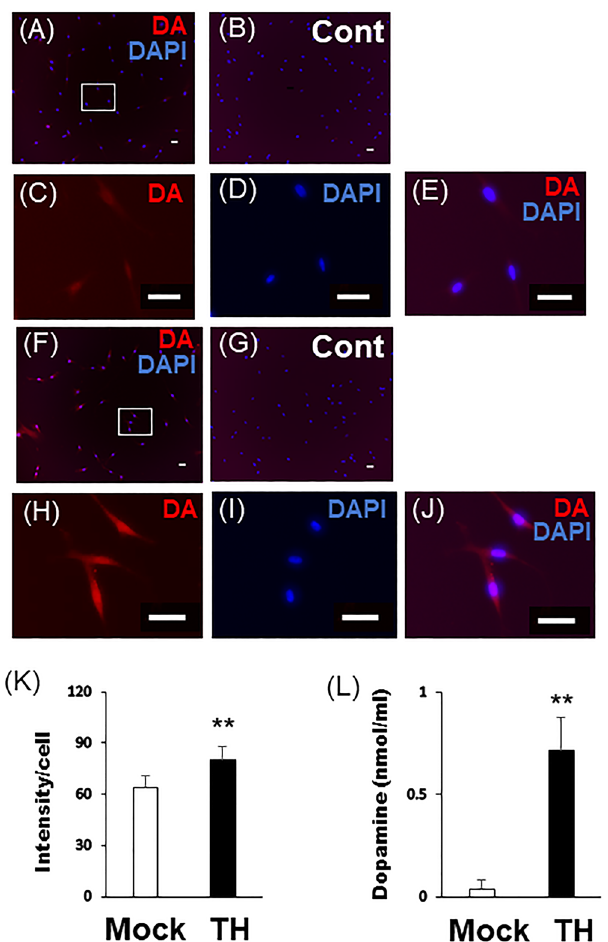
Figure 4. Dopamine production in Mock- or TH-DPSCs-3U. ( A – J ) Immunofluorescence staining of Mock- DPSCs or TH-DPSCs with anti-DA antibody (red) was performed. ( B , G ) Rabbit control IgG (cIgG) was used as a negative control. ( C – E ) Magnified images of the white boxed areas in ( A ). ( H – J ) Magnified images of the white boxed areas in ( F ). Nuclei were stained with DAPI. Bars = 50 μm. ( K ) Intensity of immunofluorescence staining of DA were quantified using a Keyence BZ-9000 microscope with BZ-H4M/BZ-H4C/BZ-H4CM software. ( L ) Mock-DPSCs or TH-DPSCs were cultured in DM for 30 min. The concentration of DA of each culture supernatant was measured by ELISA analysis. Statistical analysis was performed using the Student’s unpaired t-test with Easy R software. n = 3, ** P <